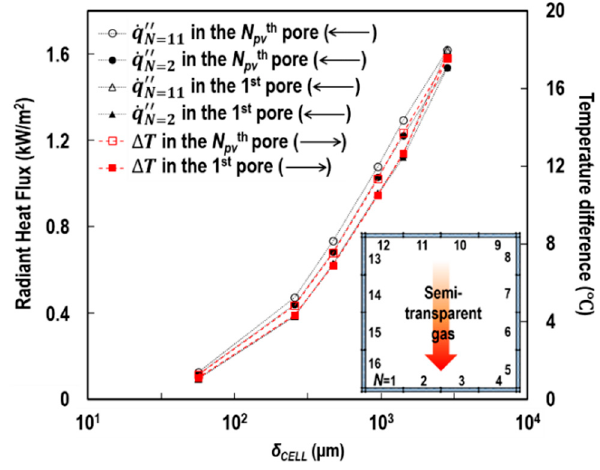
Figure 18. Variations in 𝑞(cid:4662) (cid:3038)(cid:4593)(cid:4593) and Δ T according to δ cell , at L = 3 mm, Φ = 0.895, and 𝑞(cid:4662) (cid:2919)(cid:2928)(cid:2928)(cid:4593)(cid:4593) = 50 kW/m 2 .